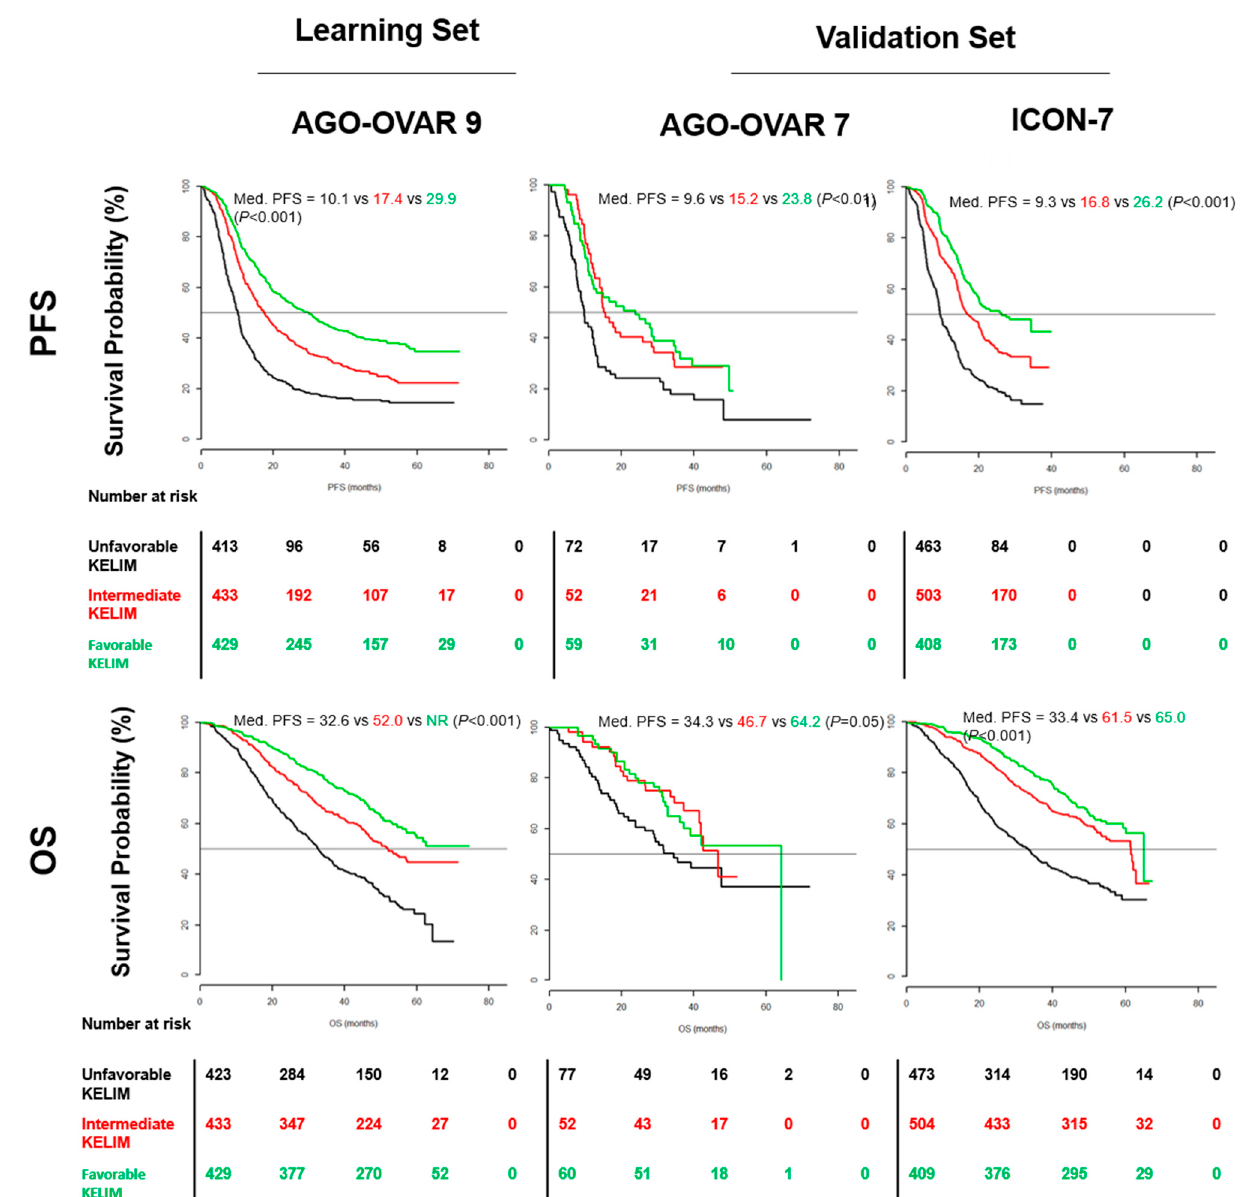
Figure 2. Kaplan–Meier analyses of PFS and OS in the learning set AGO OVAR 9 and the two vali- dation sets AGO OVAR 7 and ICON-7. Black line, unfavorable KELIM tercile (minimum–0.05) days-1; red line, intermediate KELIM tercile (0.05 − 0.07) days − 1 ; green line, favorable KELIM tercile (0.07–maximum) days − 1 ; P: univariate log-rank tests; Med.: median. (Adjusted from Colomban et al., Clin Cancer Res 2019 [23]).